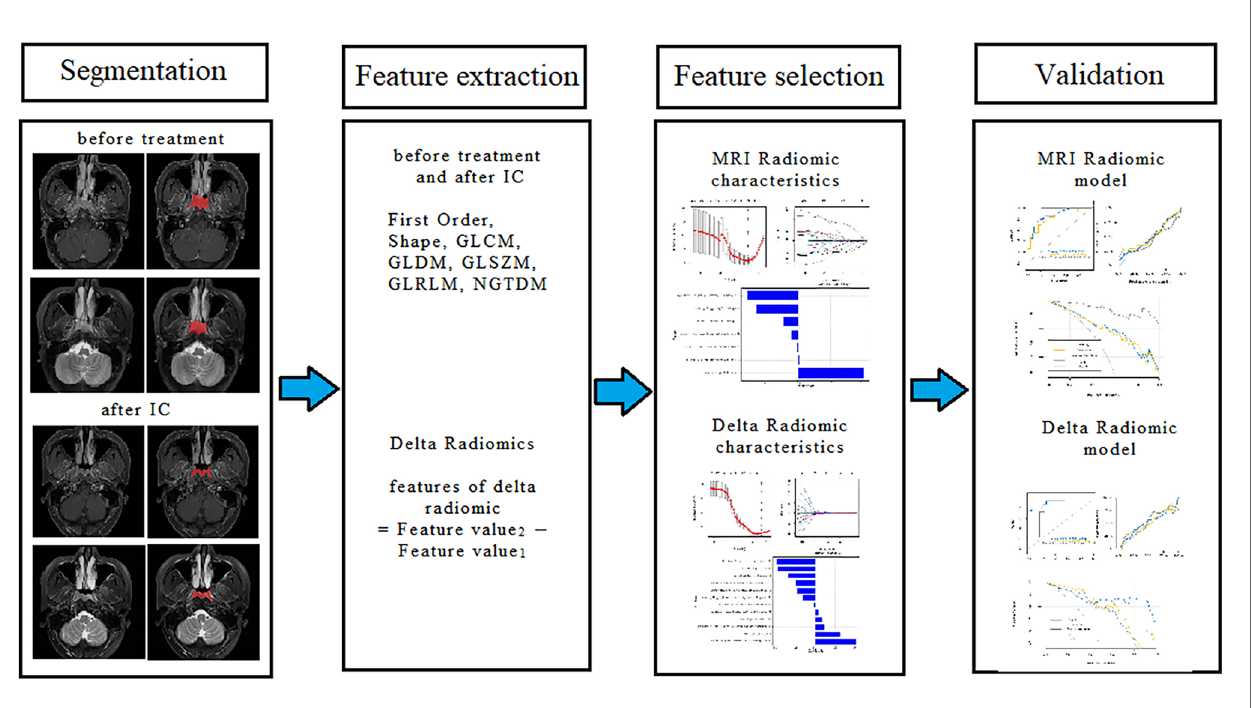
FIGURE 2 | Flow diagram of